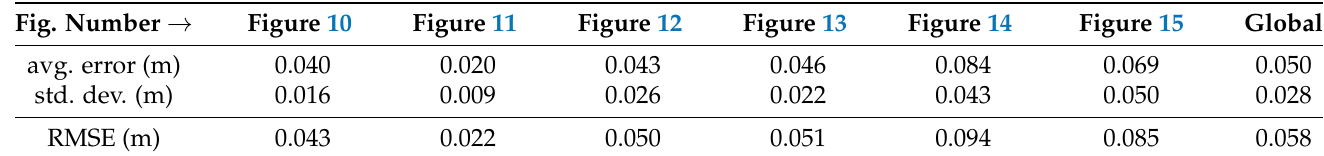
Table 1. Position estimation error